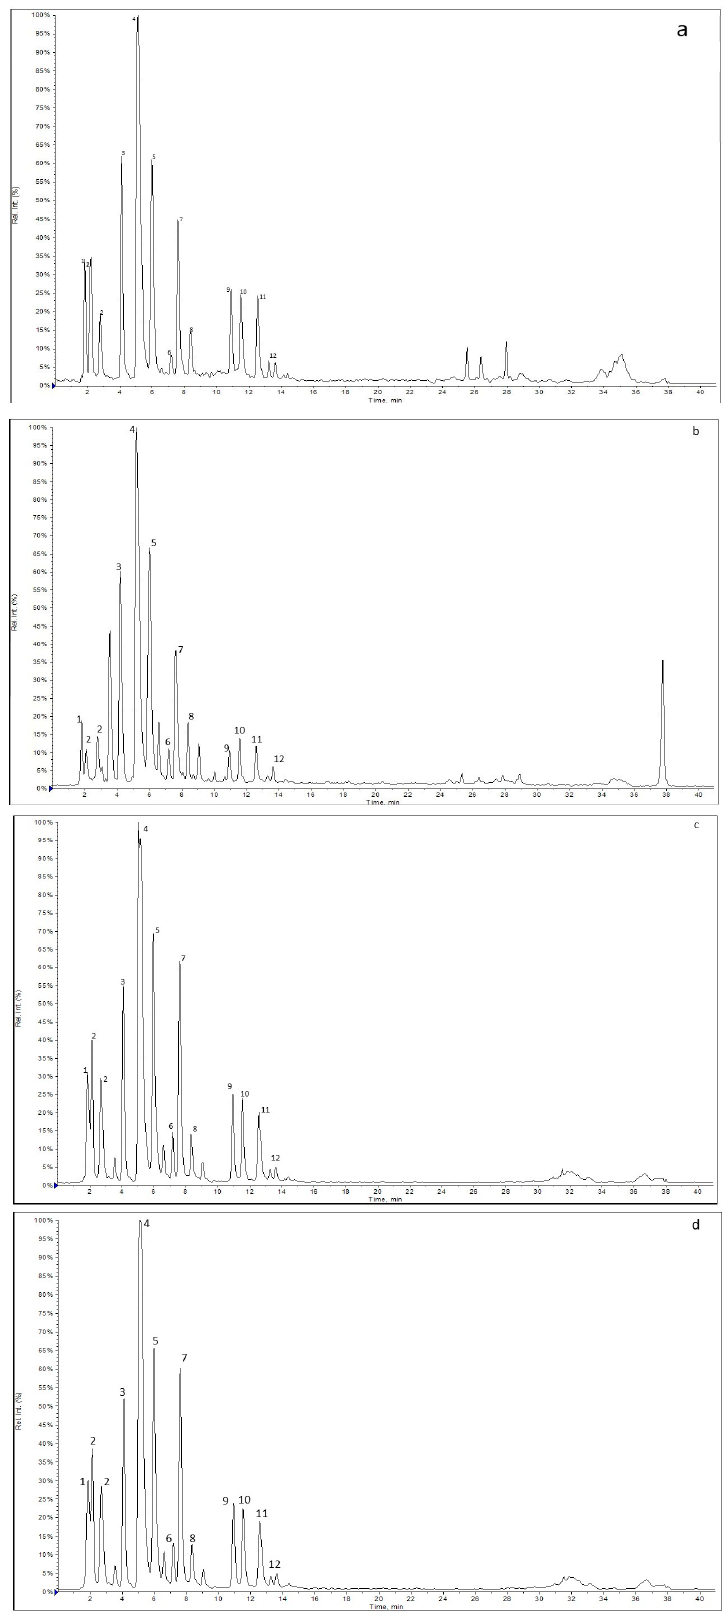
1 Figure 1. Extracted ion chromatograms (XIC) obtained for ( a ) GC, ( b ) F7, ( c ) F14 and ( d ) F28